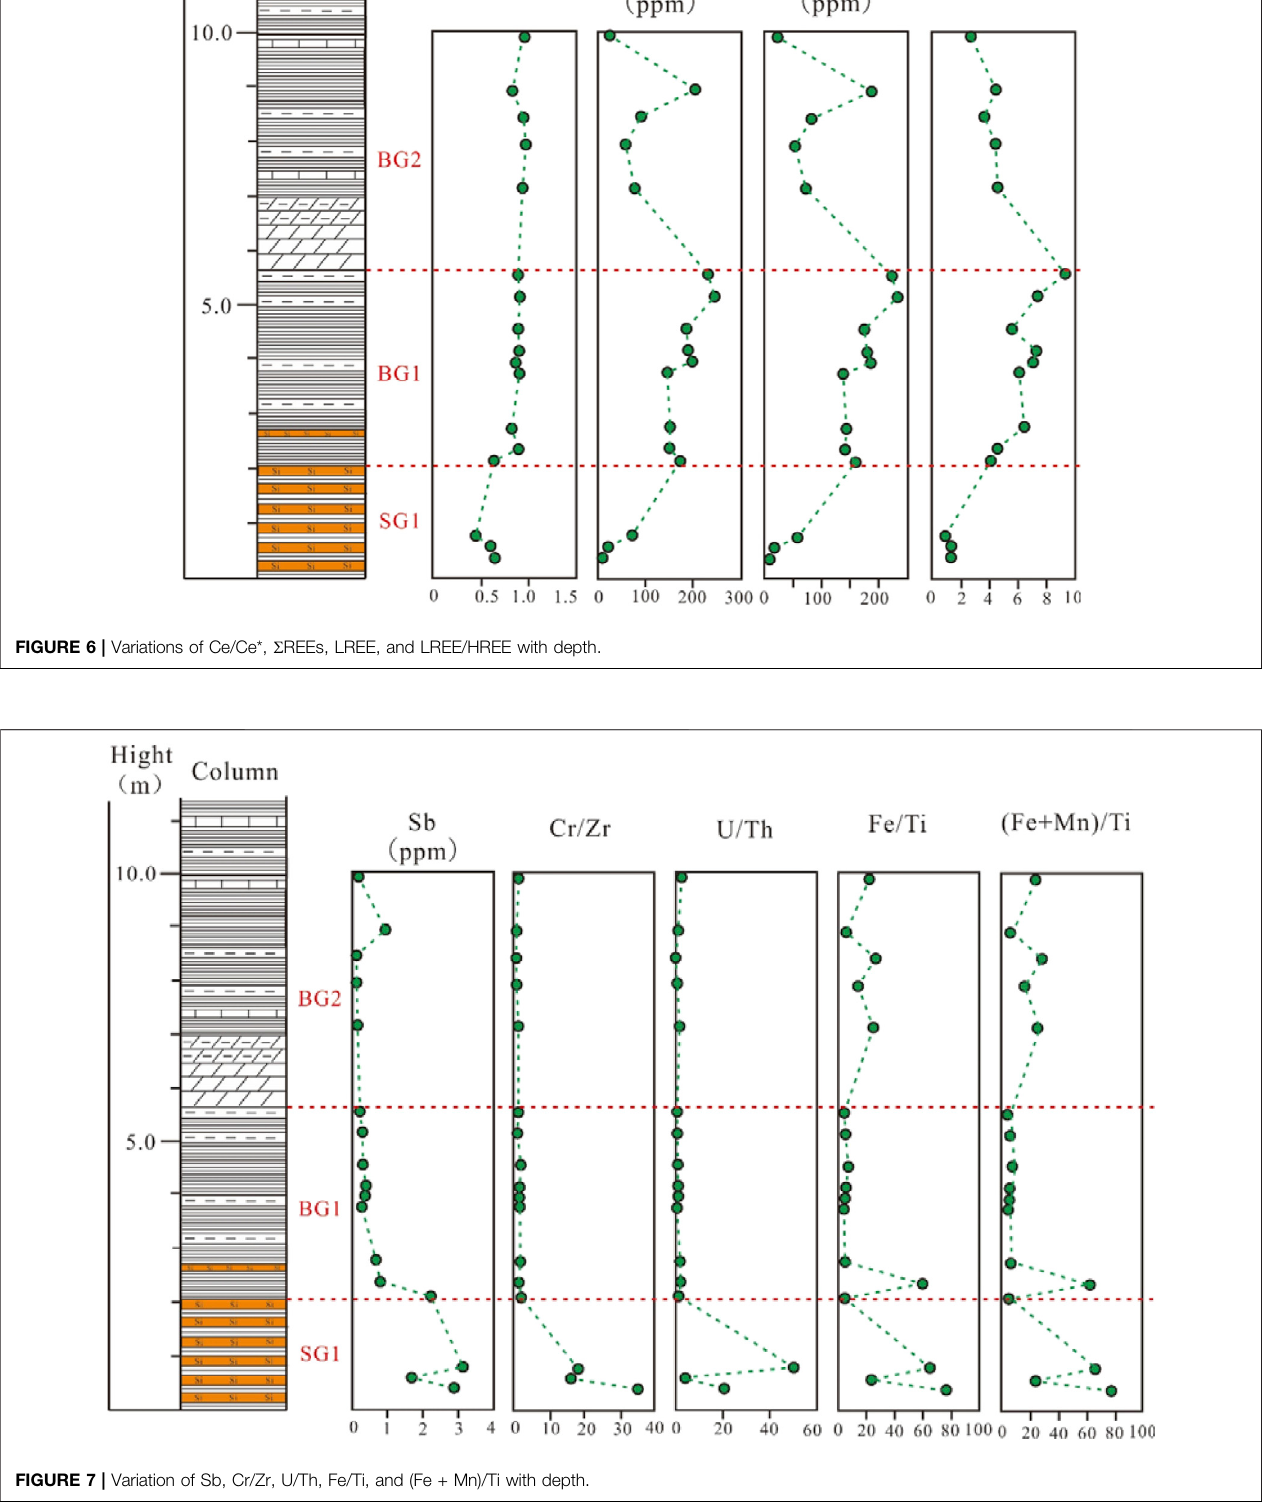
Frontiers in Earth Science |